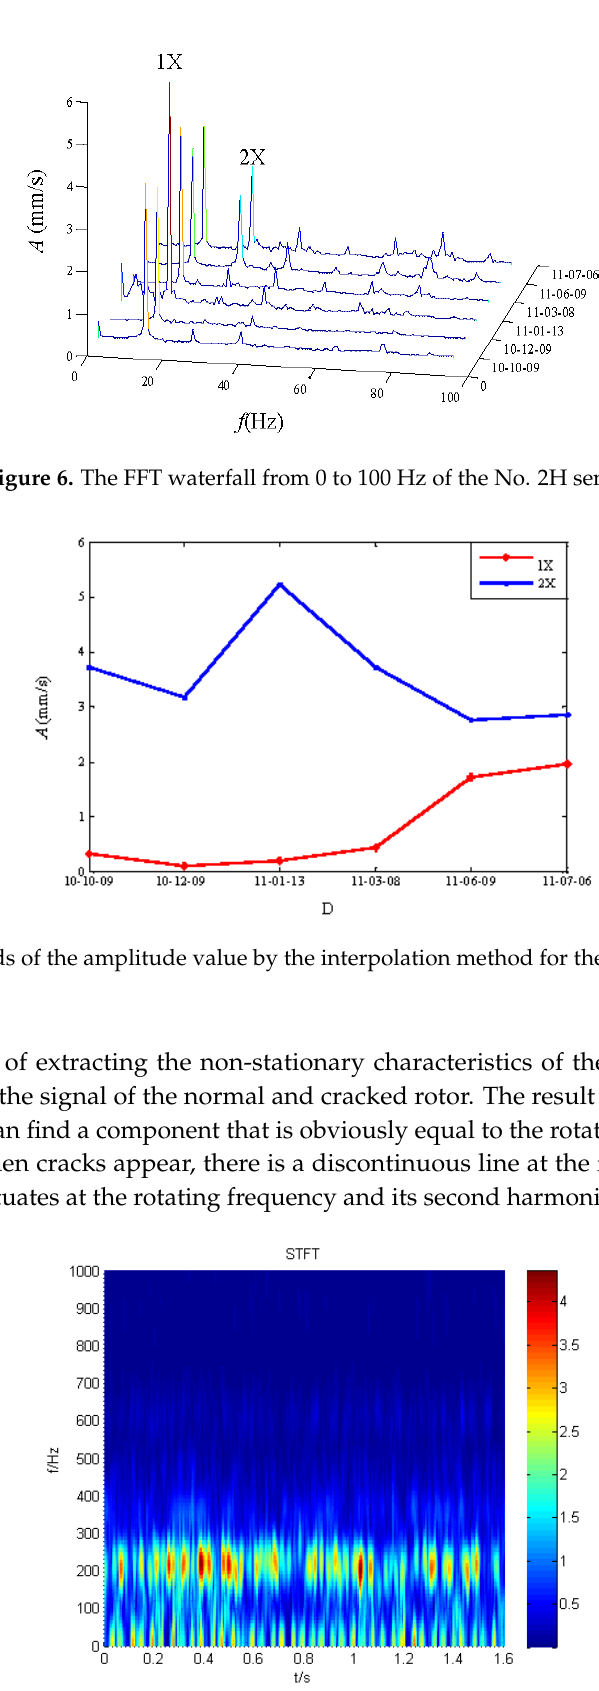
Figure 8. The STFT result acquired from a normal blade.